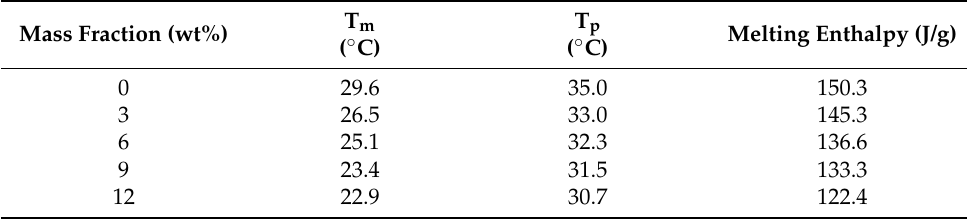
Table 2. Thermal characteristics of composite PCMs with different DHPT content.